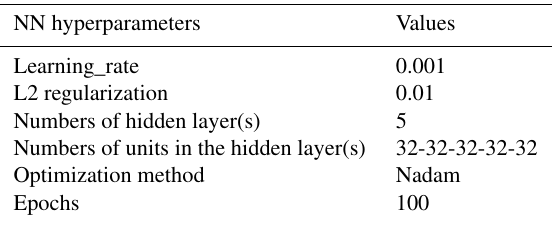
Table 7. Descriptive statistics by